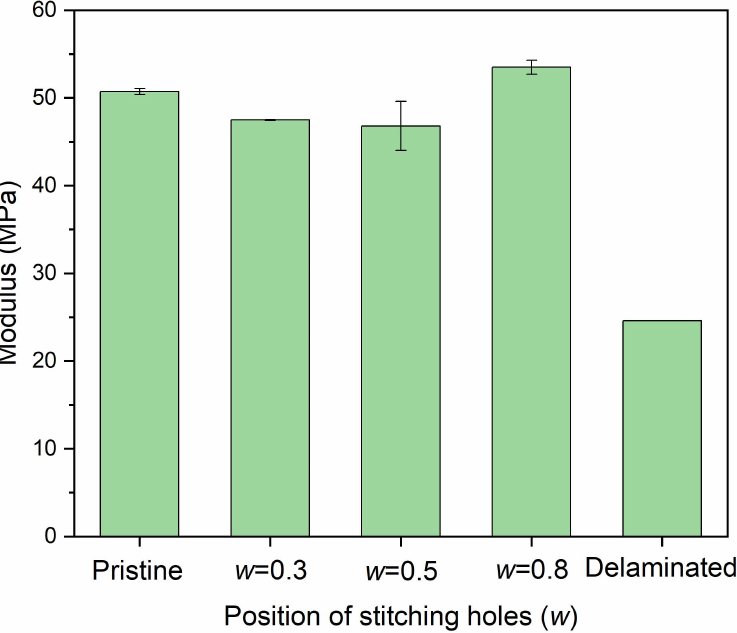
Figure 13. In-plane compressive modulus of delaminated plates after stitching repair with different diameters of stitching holes in which 6 stitching holes of 2.5 mm diameter were adopted.